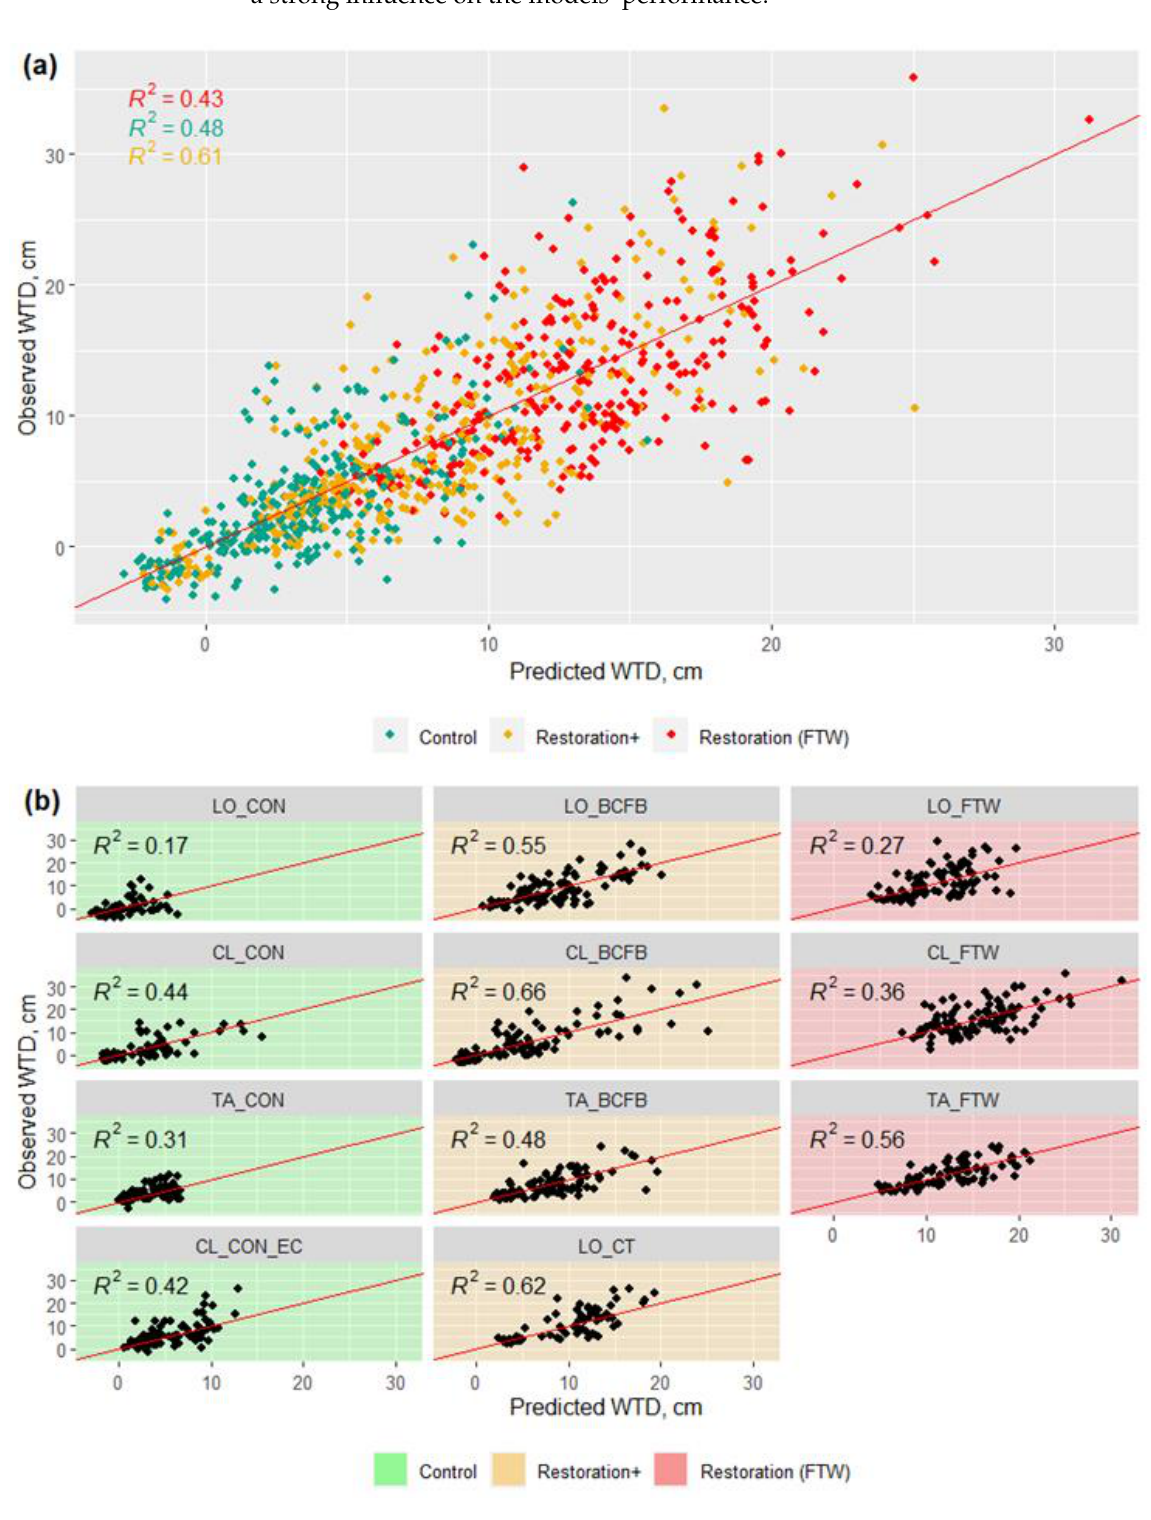
Figure 9. RF model output for Forsinard Flows sites (predicted vs. observed WTD) for ( a ) all data points and ( b ) splitting data into the individual sites. The red line represents a perfect agreement between the prediction and the field measurement.